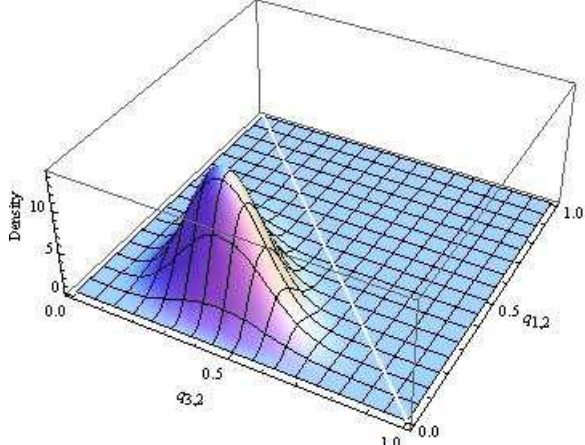
Figure 3. The Dirichlet distribution function for Pl 2 showing q 3,2 and q 1,2 , where q 2,2 has been determined for all combinations of q 3,2 and q 1,2 as 1- q 3,2 - q 1,2 .